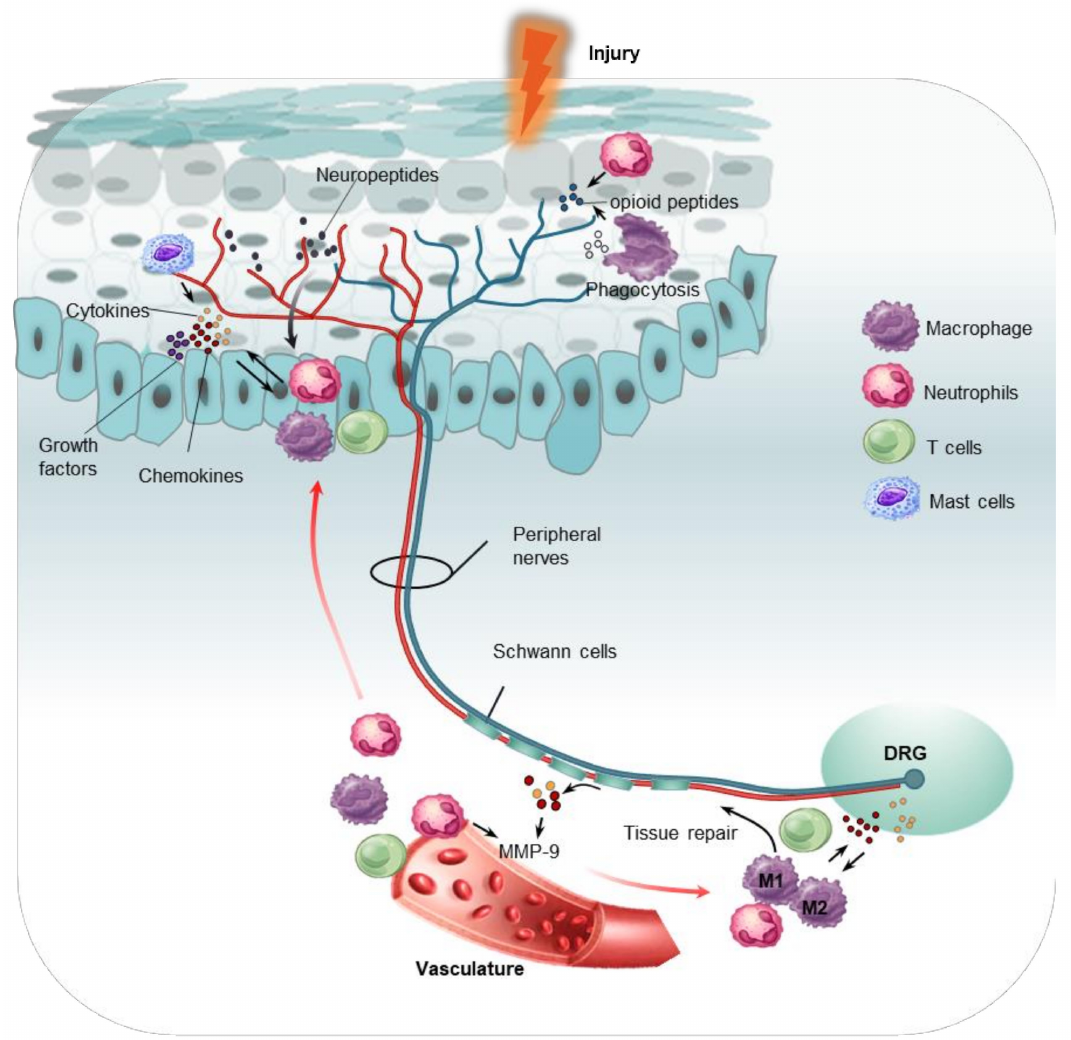
Figure 2. Interactions between distinct parts of the PNS with immune cells (neutrophils, macrophages, mast cells and T cells). Upon stimuli, injury initiates the release of inflammatory mediators (cytokines and chemokines) that cause degranulation of mast cells close to the nerve terminal, resulting in proinflammatory production. Nociceptive nerve terminals secrete neuropeptides through antidromic activation of neighboring nerve terminal branches to attract immune cells. Activated Schwann cells and neutrophils mediate breakdown of the blood–nerve barrier via the secretion of matrix metalloproteinase 9(MMP-9), promoting infiltration of immune cells including macrophages, T cells to the DRG and peripheral nerve ending. These cells, once activated, release a battery of inflammatory mediators (growth factors, cytokines, and chemokines) that act on receptors expressed on adjacent nociceptor nerve terminals, leading to nociceptor sensitization. Macrophages exhibit functions in mediating phagocytosis and tissue repair. Both macrophages and neutrophils inhibit nociceptive effects by releasing opioid peptides at injury